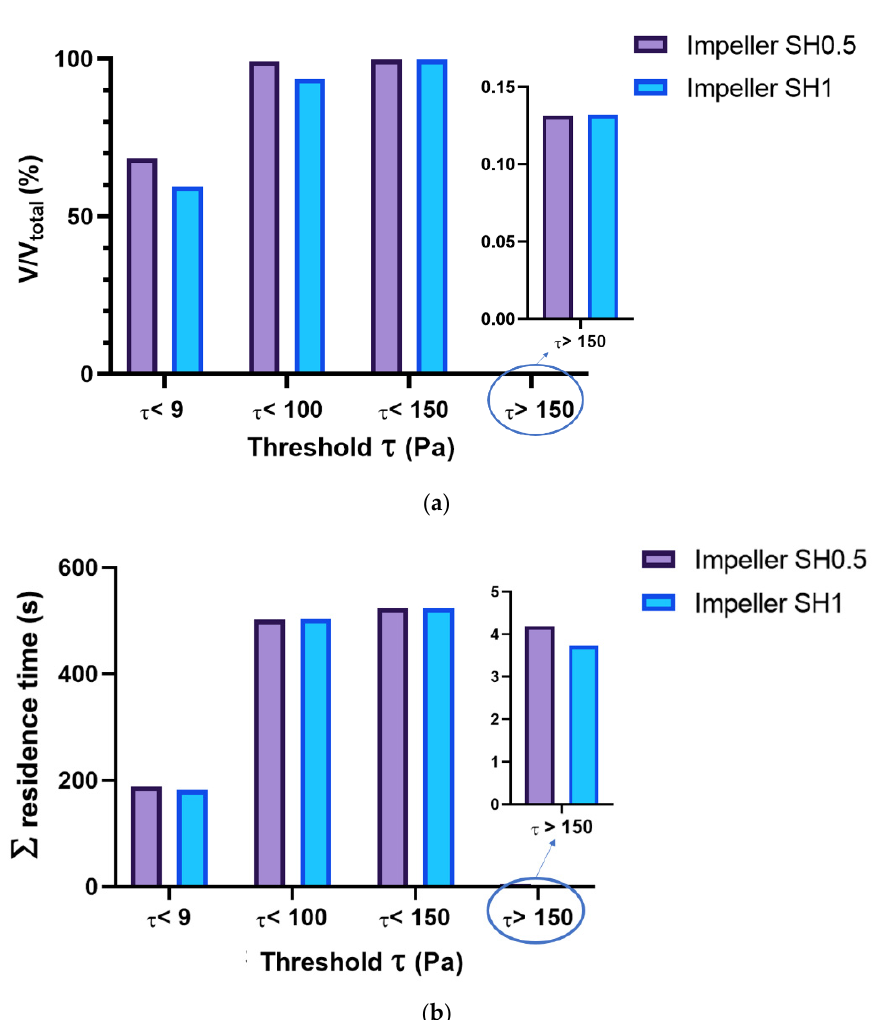
Figure 11. ( a ) Volume fractions and ( b ) the sum of cell residence times, subjected to the speci fi c shear stress thresholds.